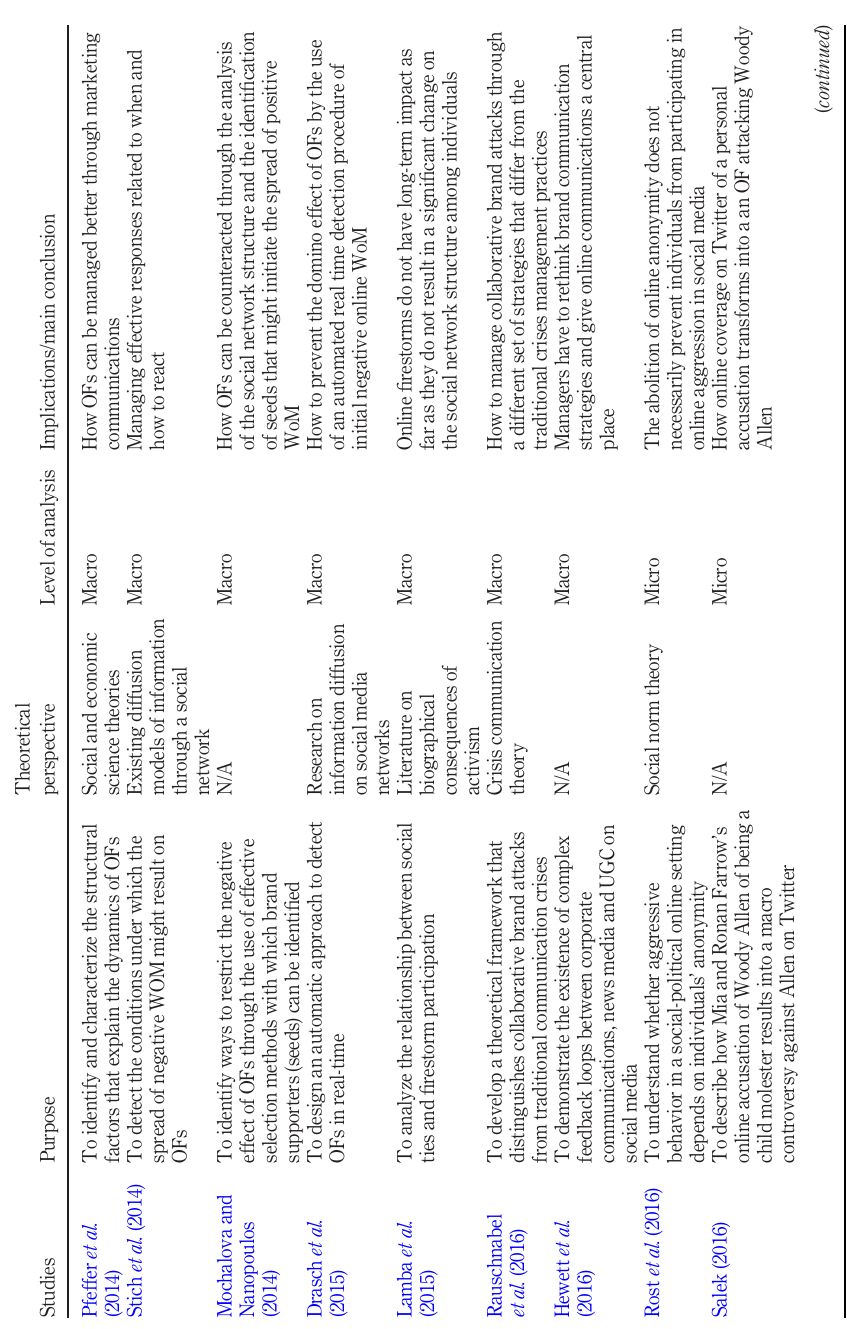
Table I. Main studies on